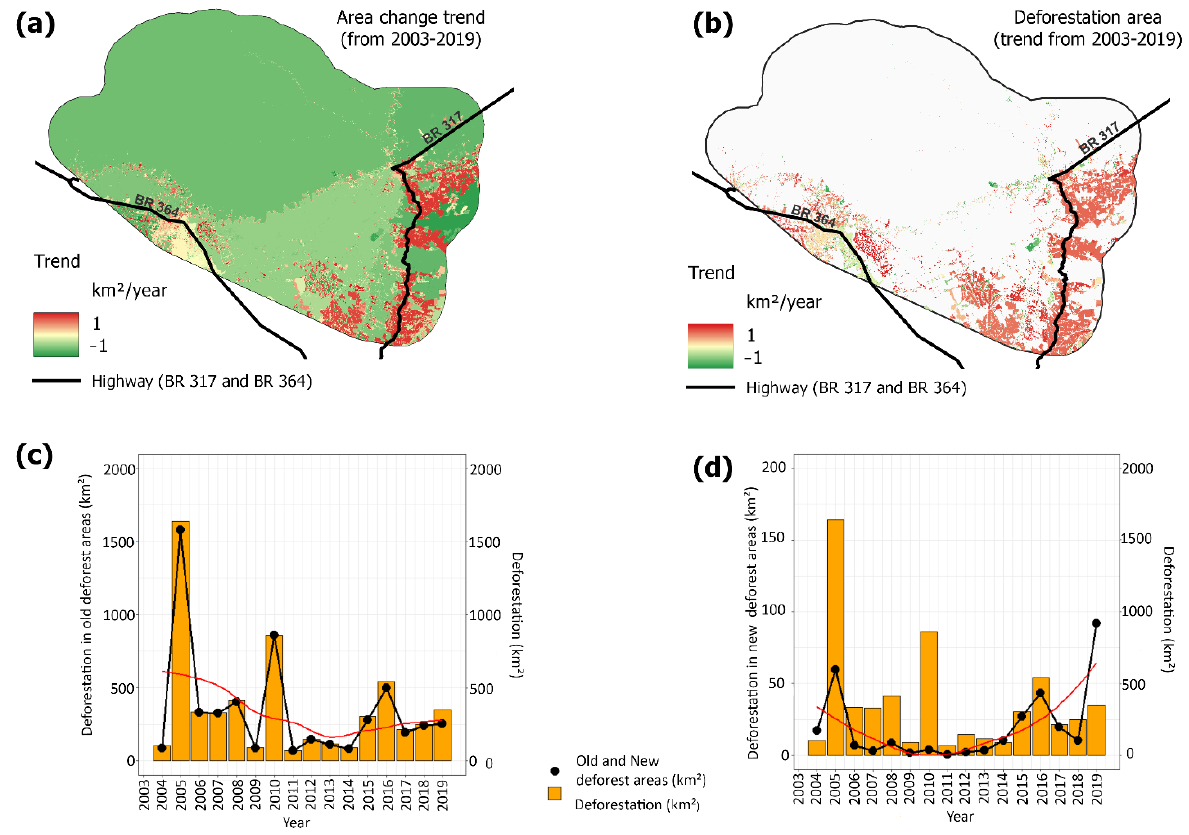
Figure 6. ( a ) Spatial trends for area (30 m spatial resolution) between 2003 and 2019, negative values (in green) represent at decreasing trend, while positive values (in red) represent an increasing trend. ( b ) Spatial trends for area (30 m spatial resolution) between 2003 and 2019, negative values (in green) represent at decreasing trend, while positive values (in red) represent an increasing trend. ( c ) Burned area in old deforest areas from 2003 to 2019 in the study region. ( d ) Burned area in new deforest areas from 2003 to 2019 in the study region3.4. Fire Extent and Land Tenure